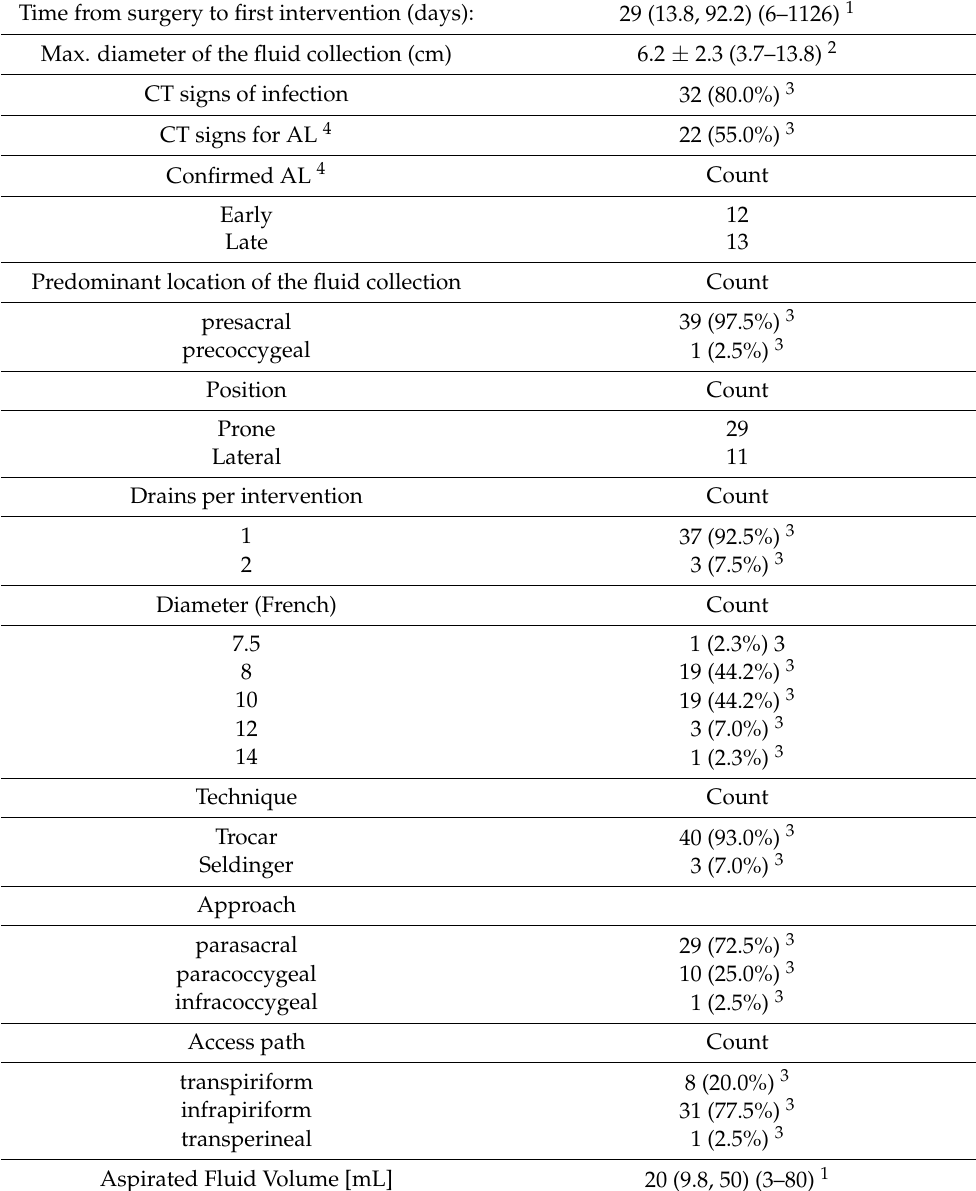
Table 2. Information on intervention situs, drains and technique in the 40 CTD procedures. Time from surgery to first intervention